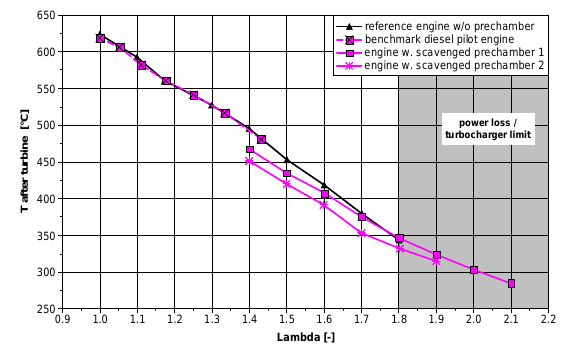
Fig. 23. Temperature after turbine for the operating point 2 (2000 rpm/220 Nm)